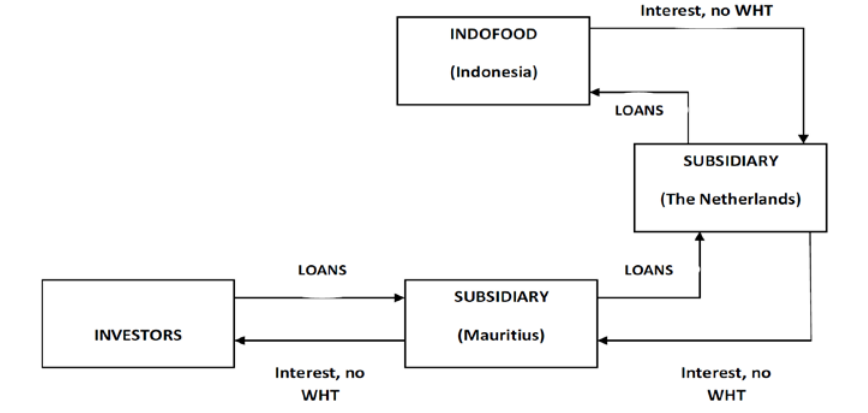
FIGURE 1: The tax planning scheme in the Indofood case Source: Vitko,